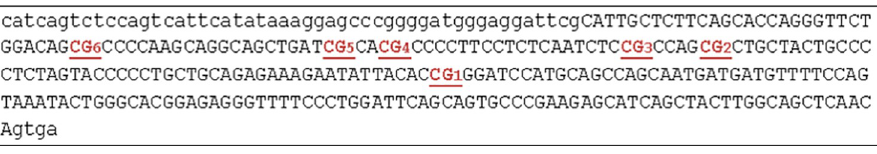
Fig 1. Sequence overview. Fig 1 represents the location of CpG sites, of which methylation was